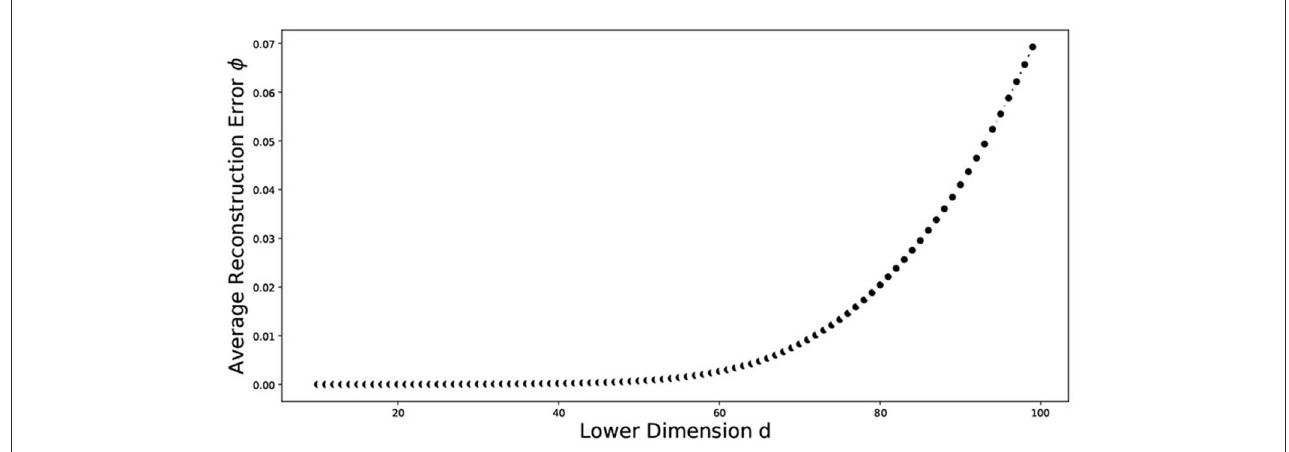
FIGURE6 Plot of the average reconstruction error vs dimension of the data. The average was taken over ten random replications of the training data set of size